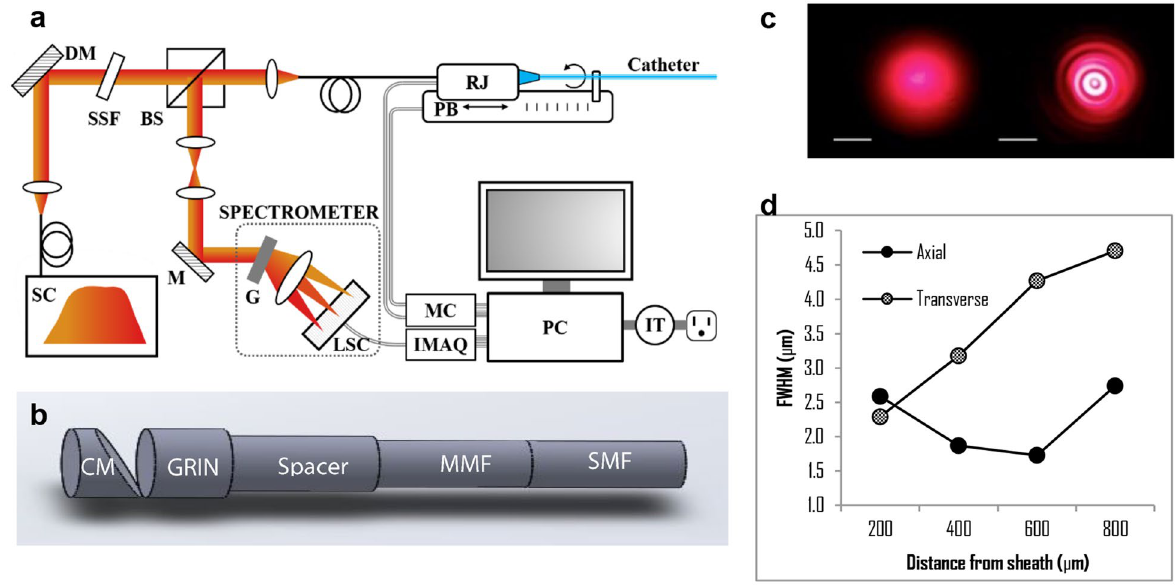
Figure 3. ( a ) Schematic depicting the elements comprising the μOCT system that is interfaced with an endomicroscope for intracochlear imaging. DM dichroic mirror, SSF spectral shaping filter, BS beamsplitter, PB pullback stage, RJ rotary junction, SC supercontinuum laser, M mirror, G diffraction grating; LSC line scan camera, MC motor controller, IMAQ image acquisition board, PC personal computer; IT isolation transformer 10 . ( b ) Schematic depiction of the μOCT probe. CM cylindrical mirror, GRIN graded refractive index lens, MMF multimode fiber, SMF single mode fiber. ( c ) Plot showing system and probe’s axial and transverse resolution, measured as the full width at half maximum (FWHM) of point spread functions as a function of distance from the probe’s outer sheath. ( d ) Far-field beam output profiles in the transverse plane for Gaussian (left) vs. pseudo- Bessel (right) beams 9 . Scales = 1 cm.